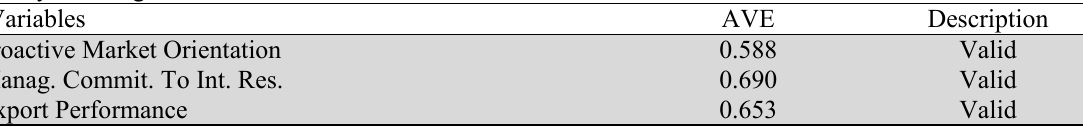
Validity Convergence Variables AVE Manag. Commit. To Int. Res.